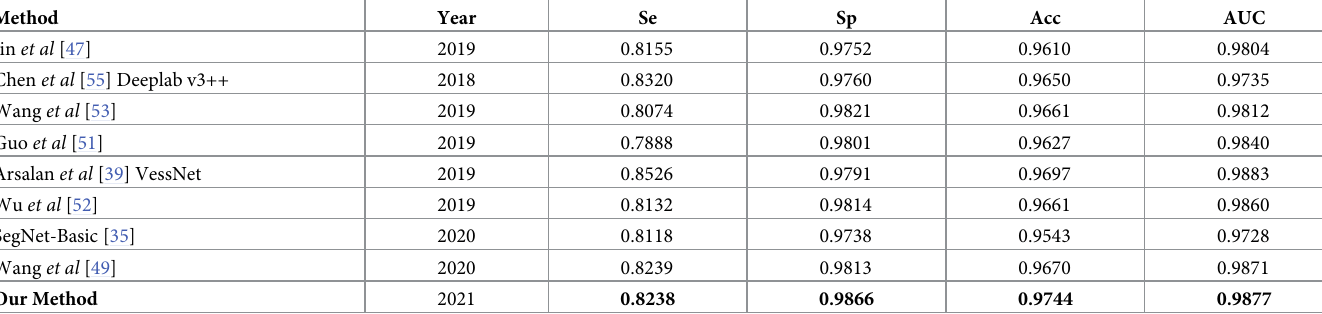
Table 7. Performance comparison of our proposed model on STARE database with other existing models.